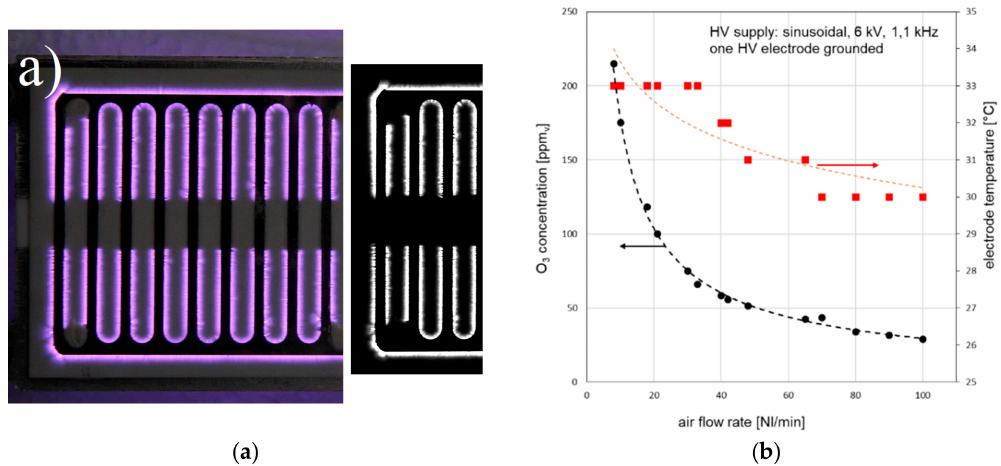
Figure 8. Surface DBD OG: ( a ) discharge pattern (real image and its digitally-processed section used for real discharge area calculation), ( b ) variations of O 3 concentration and electrode temperature at moderate airflow and optimized sinusoidal 6 kV 1.1 kHz HV power